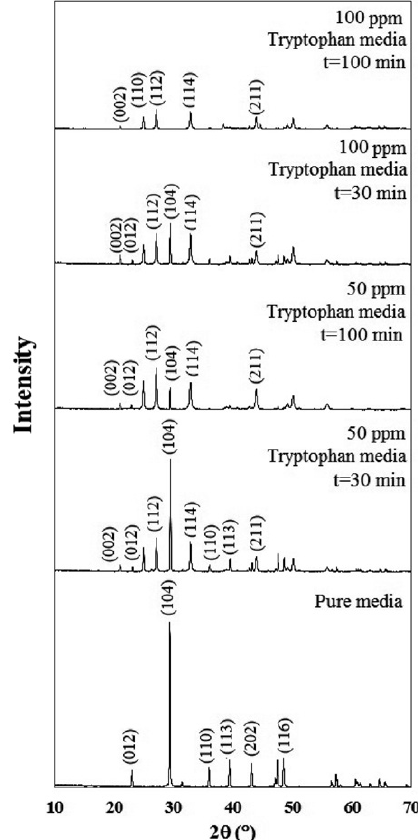
Figure 1. XRD results for CaCO 3 crystals precipitated in pure me- dia and media supplemented with 50 and 100 ppm